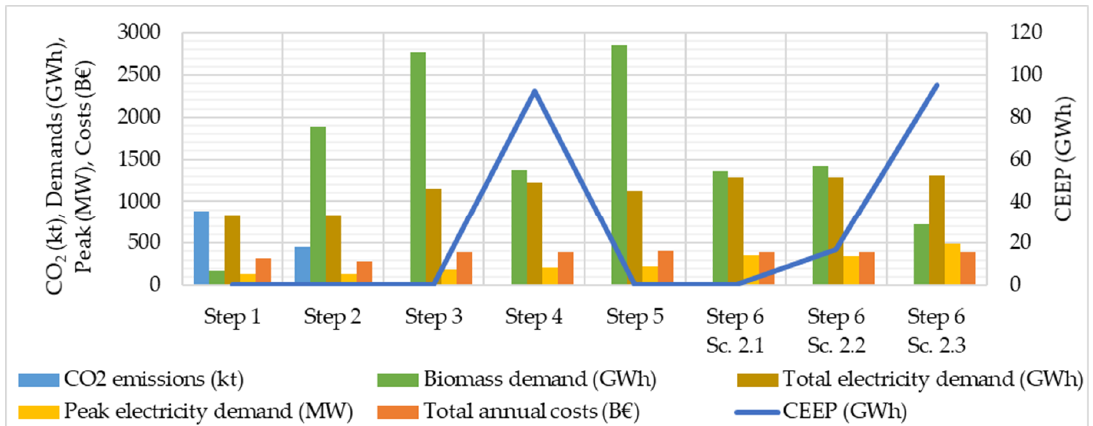
Figure 6. Overview of selected key performance indicators (KPIs) of the main scenarios.